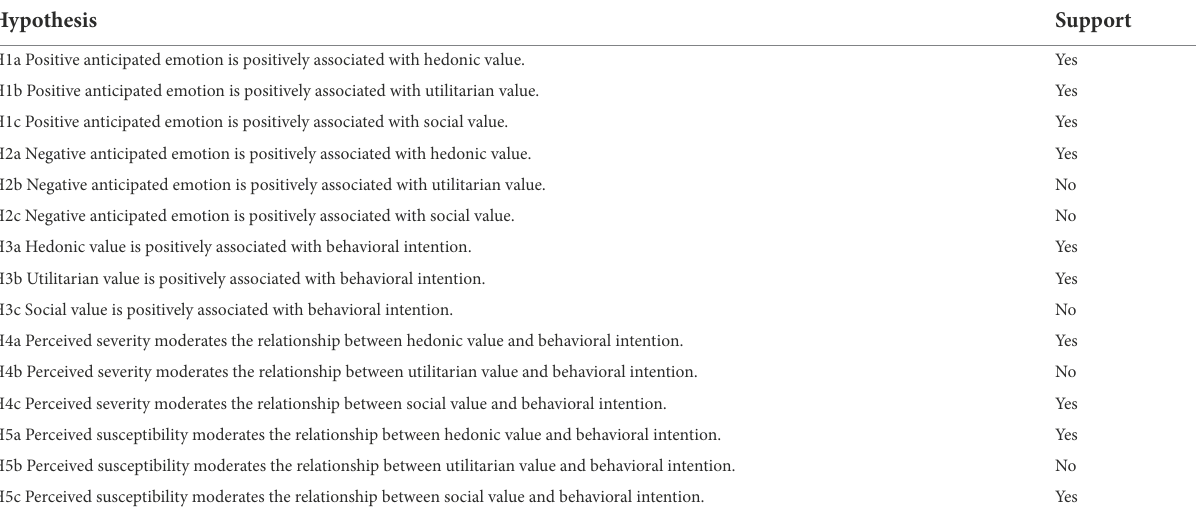
TABLE 6 Results of hypothesis